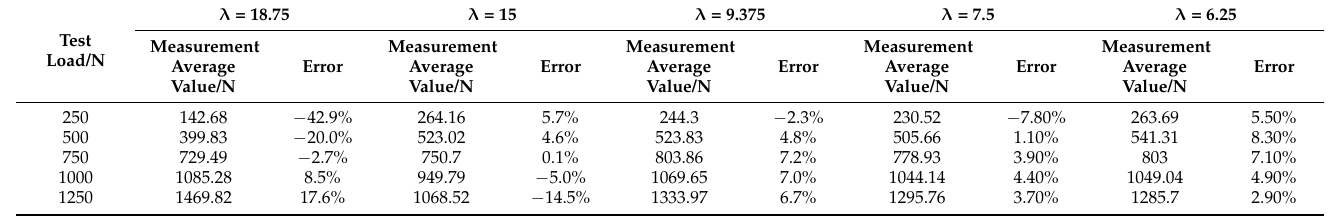
Table 1. Combined force value (N) and error of thin plate test results with different aspect ratios.